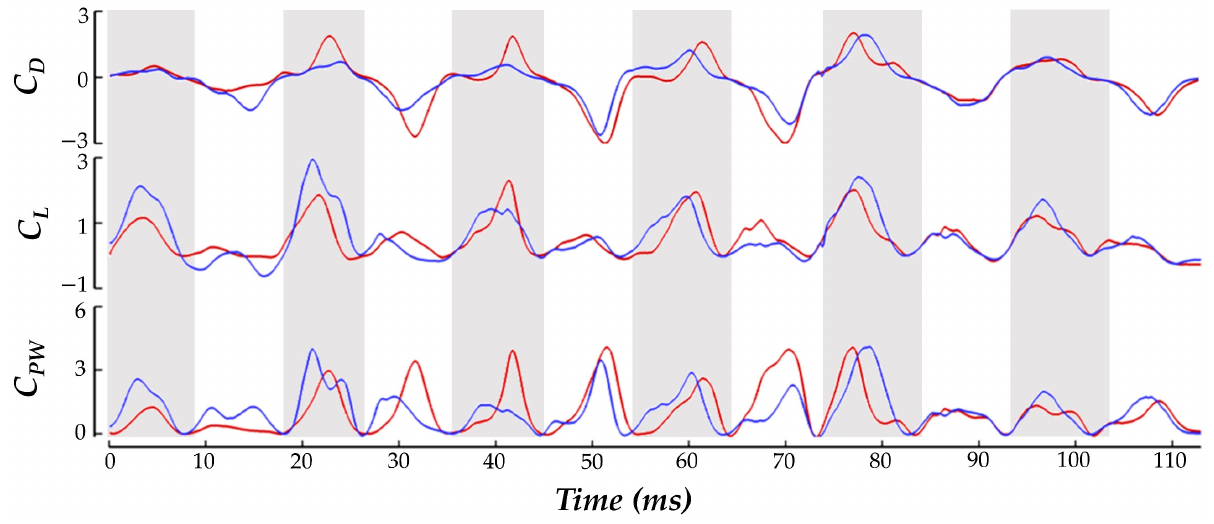
Figure 6. Time series comparison of the normalized drag, lift, and power consumption by the inner (red) and outer (blue)